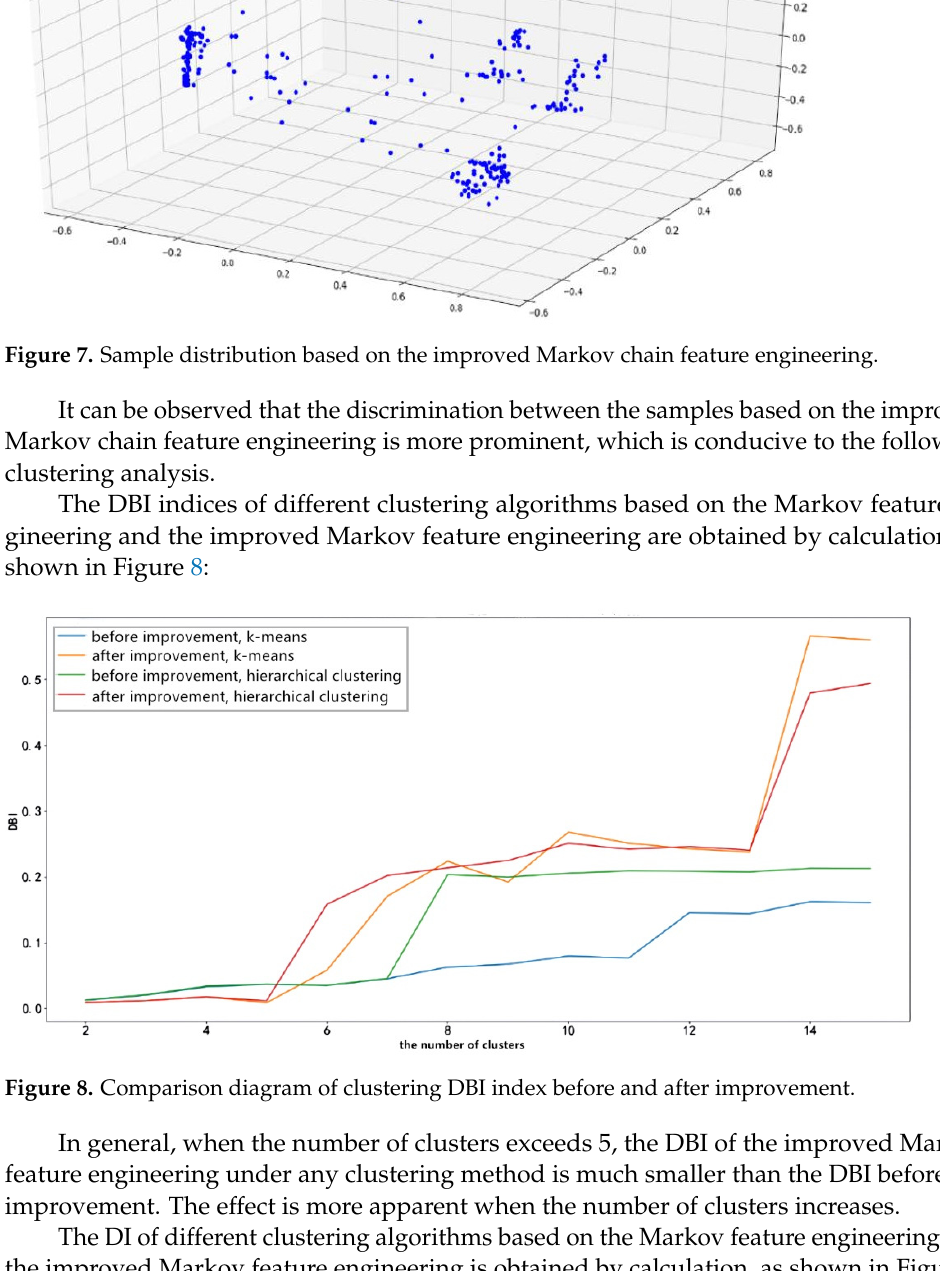
Figure 8. Comparison diagram of clustering DBI index before and after improvement.